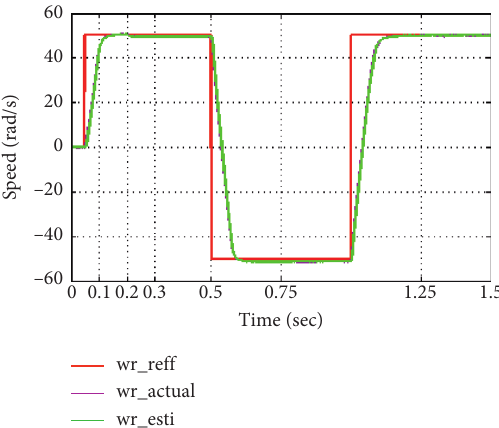
Figure 19: The actual and estimated speed performance in the regenerative